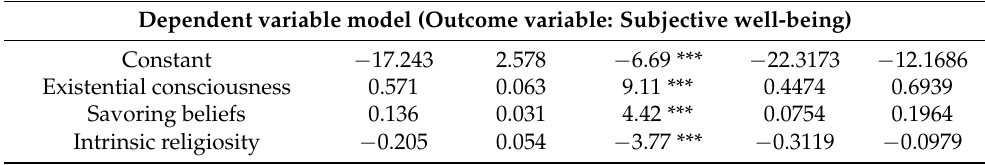
Table 4. Indirect effects of the mediation model.